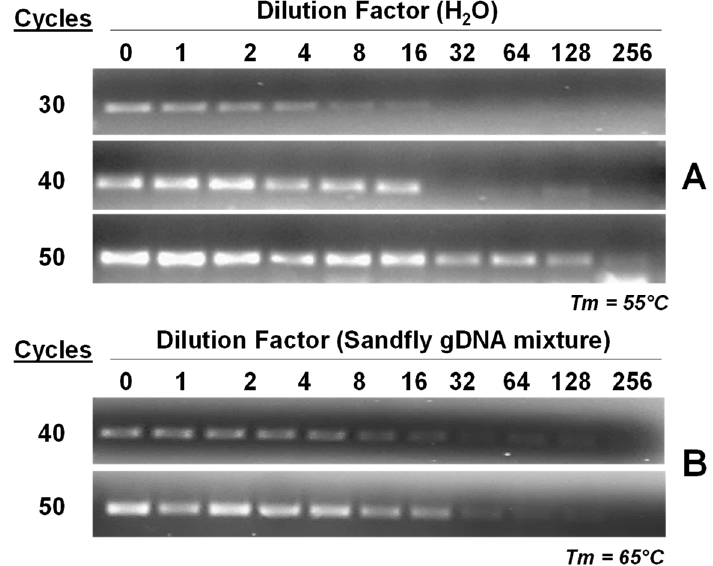
Figure 3. Sensitivity of PCR-based diagnostic assay. To examine the sensitivity of this diagnostic assay, P. papatasi samples were diluted into ddH 2 0 ( A ) or sand-fly DNA mixtures ( B ). In addition, the number of PCR cycles also contributed to the sensitivity of this rapid detection method. Dilution factor based on serial dilution ranged from 0- to 256-fold.